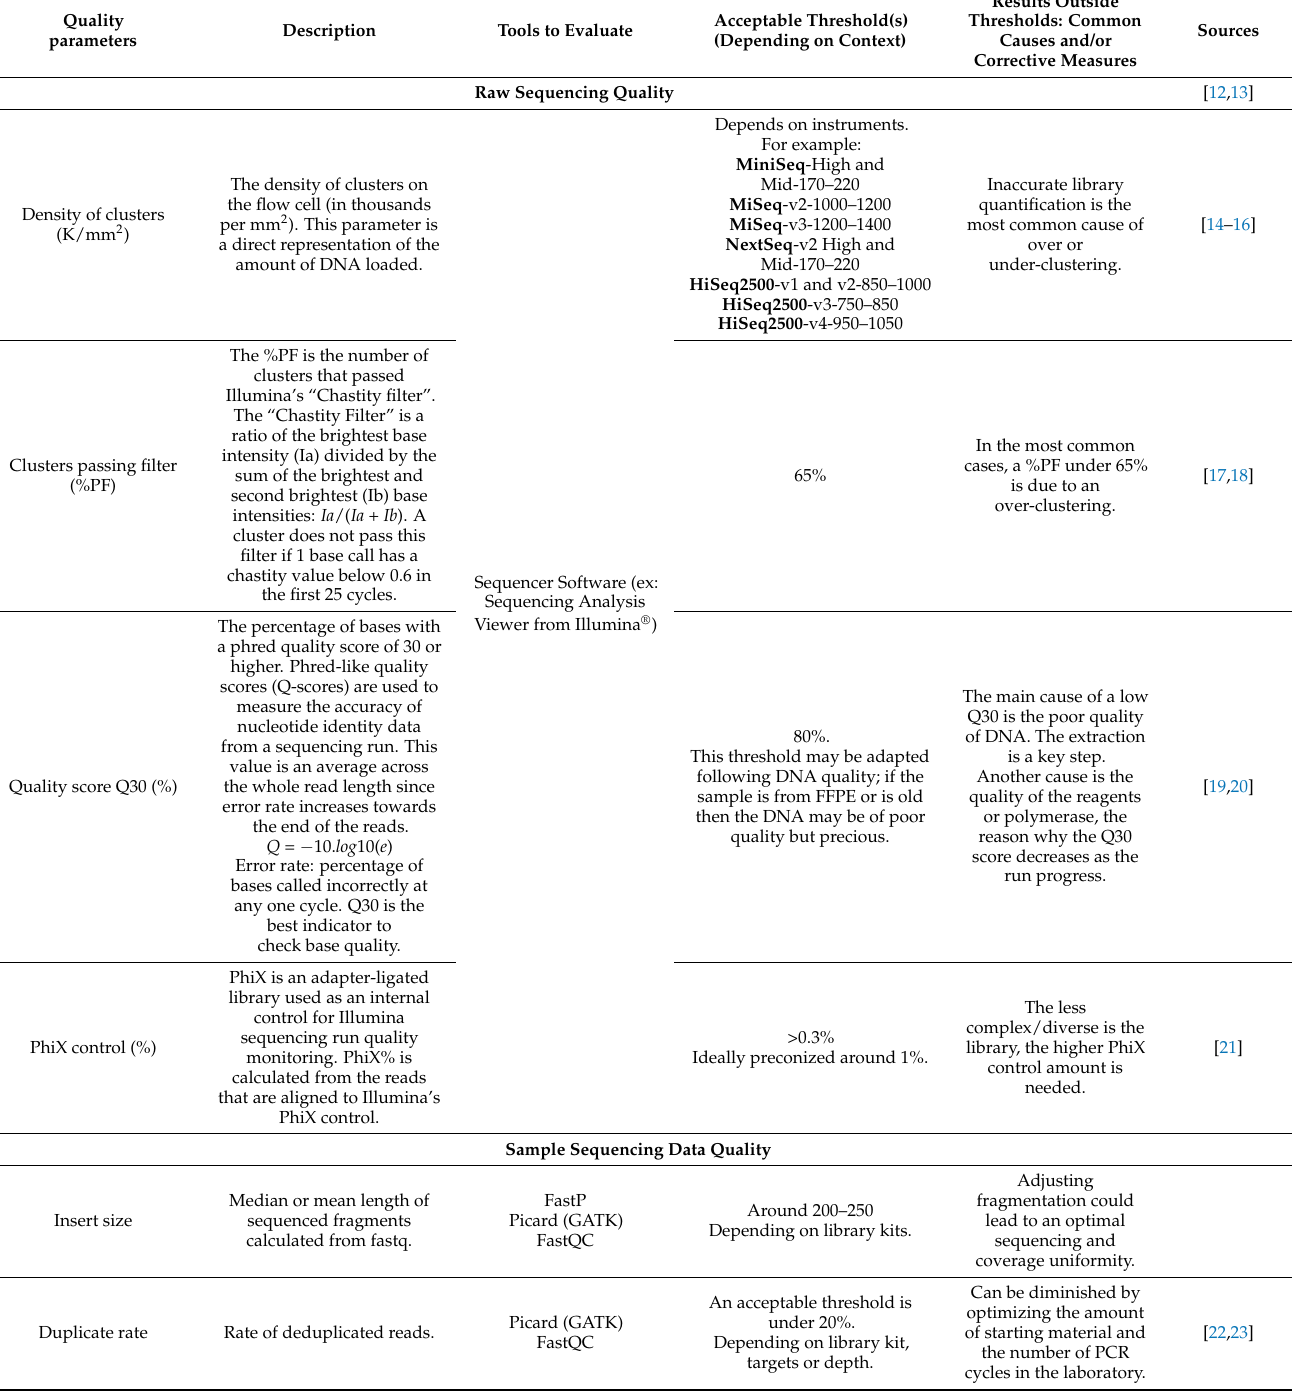
Table 1. Sequencing quality validation